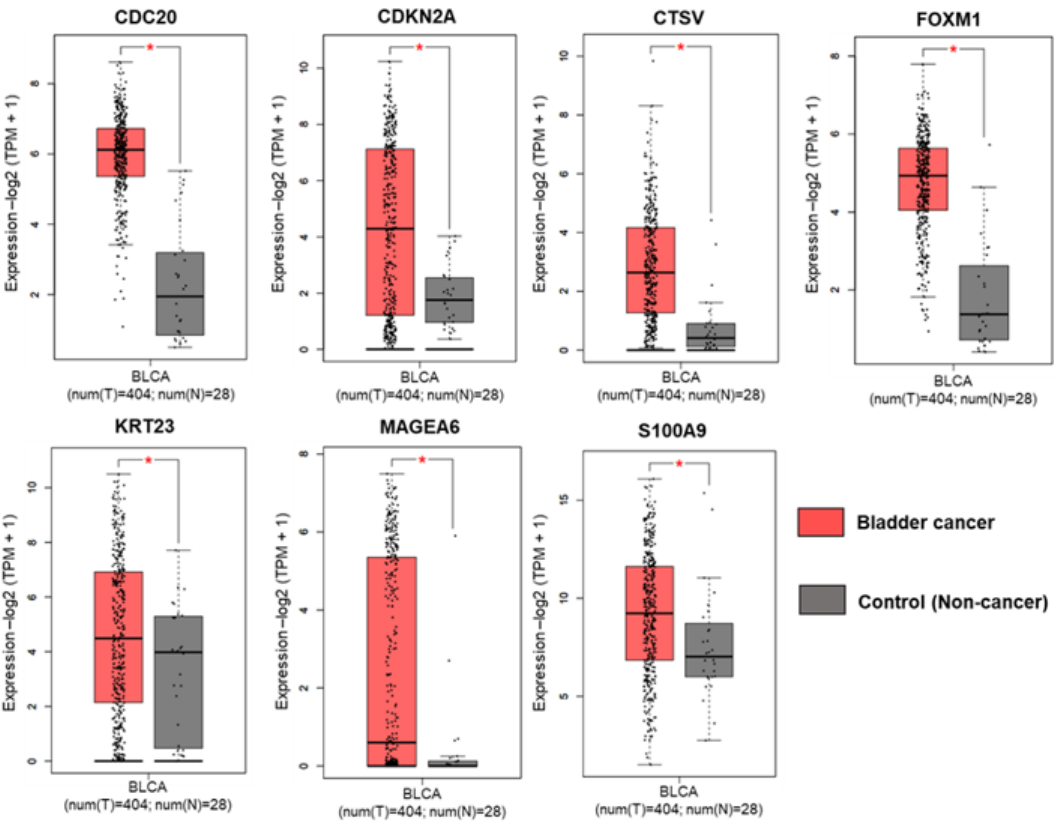
Figure 5. Expression analysis of seven gene subset in bladder cancer based on GEPIA. The expression of CDC20, CDKN2A, CTSV, FOXM1, KRT23, MAGEA6, and S100A9; * p < 0.05 was considered statistically